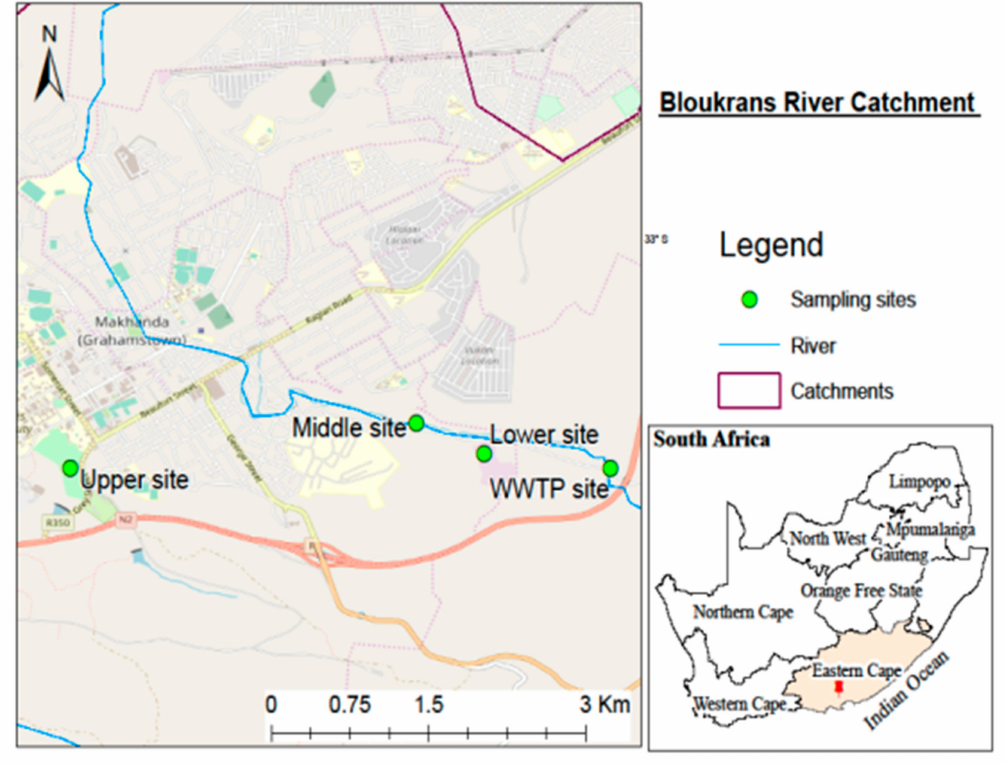
Figure 3. The map of the Bloukrans River Catchment demonstrating the study region with sampling